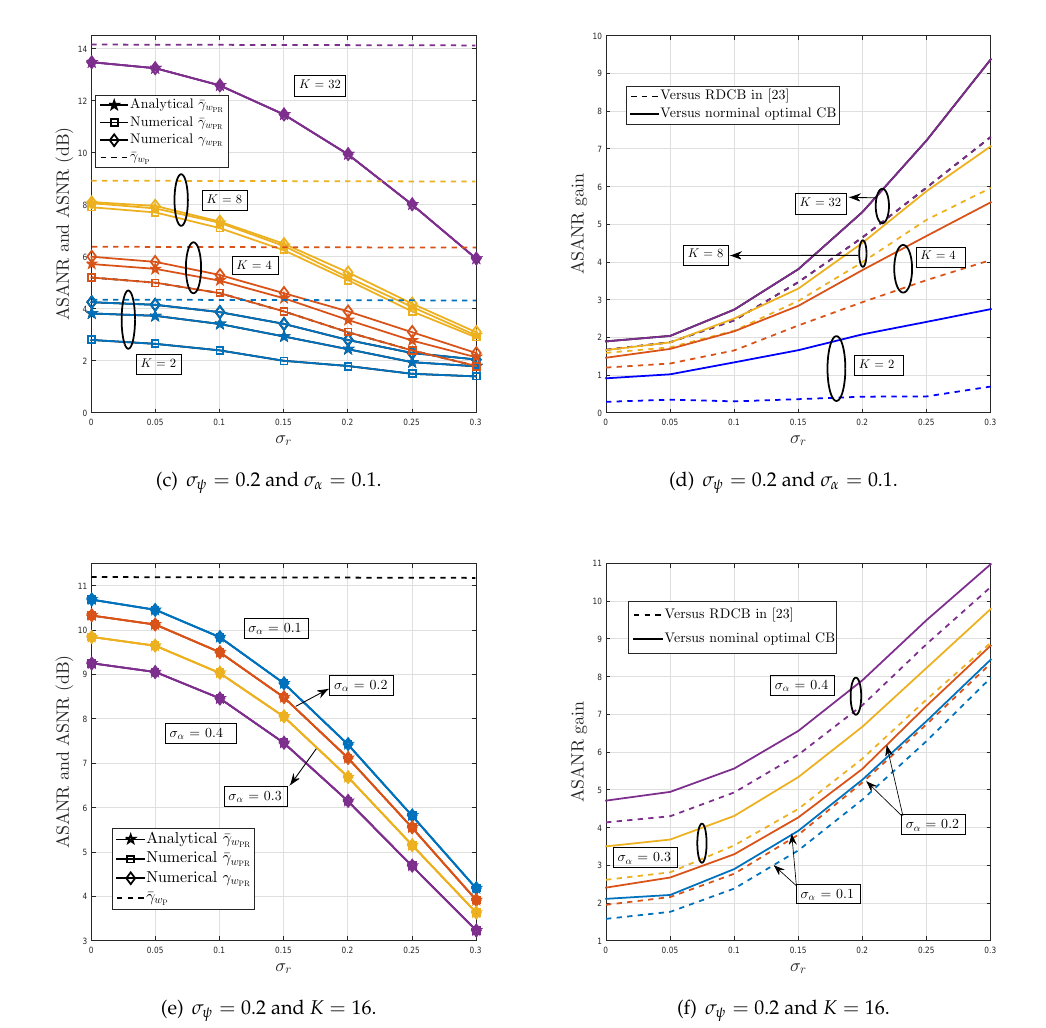
Figure 4. ASANR, ASNR, and ASANR gain of proposed P-RDCB in polychromatic